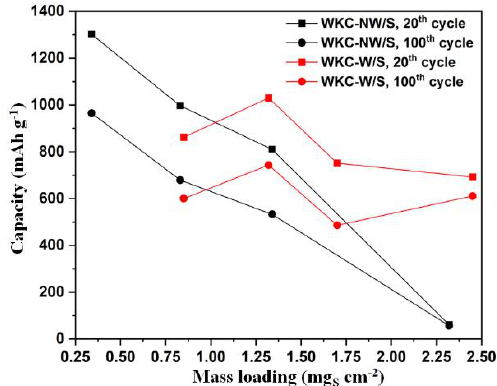
Figure 10. Comparison of the capacity values for the 20th and 100th cycles vs sulfur mass loading for WKC-NW/S (black curves) and WKC-W/S (red curves).